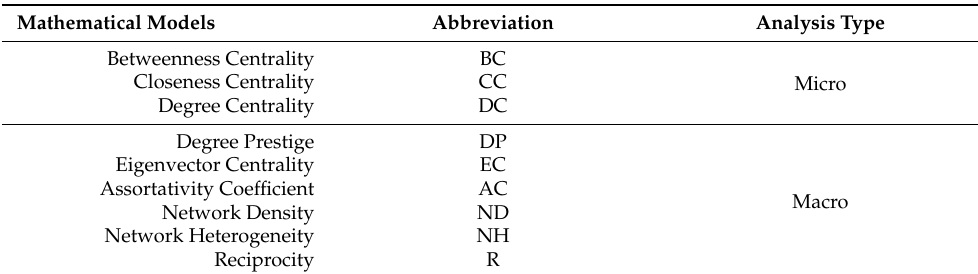
Table 1. Mathematical models which support the players’ performance evaluation metrics (adapted from